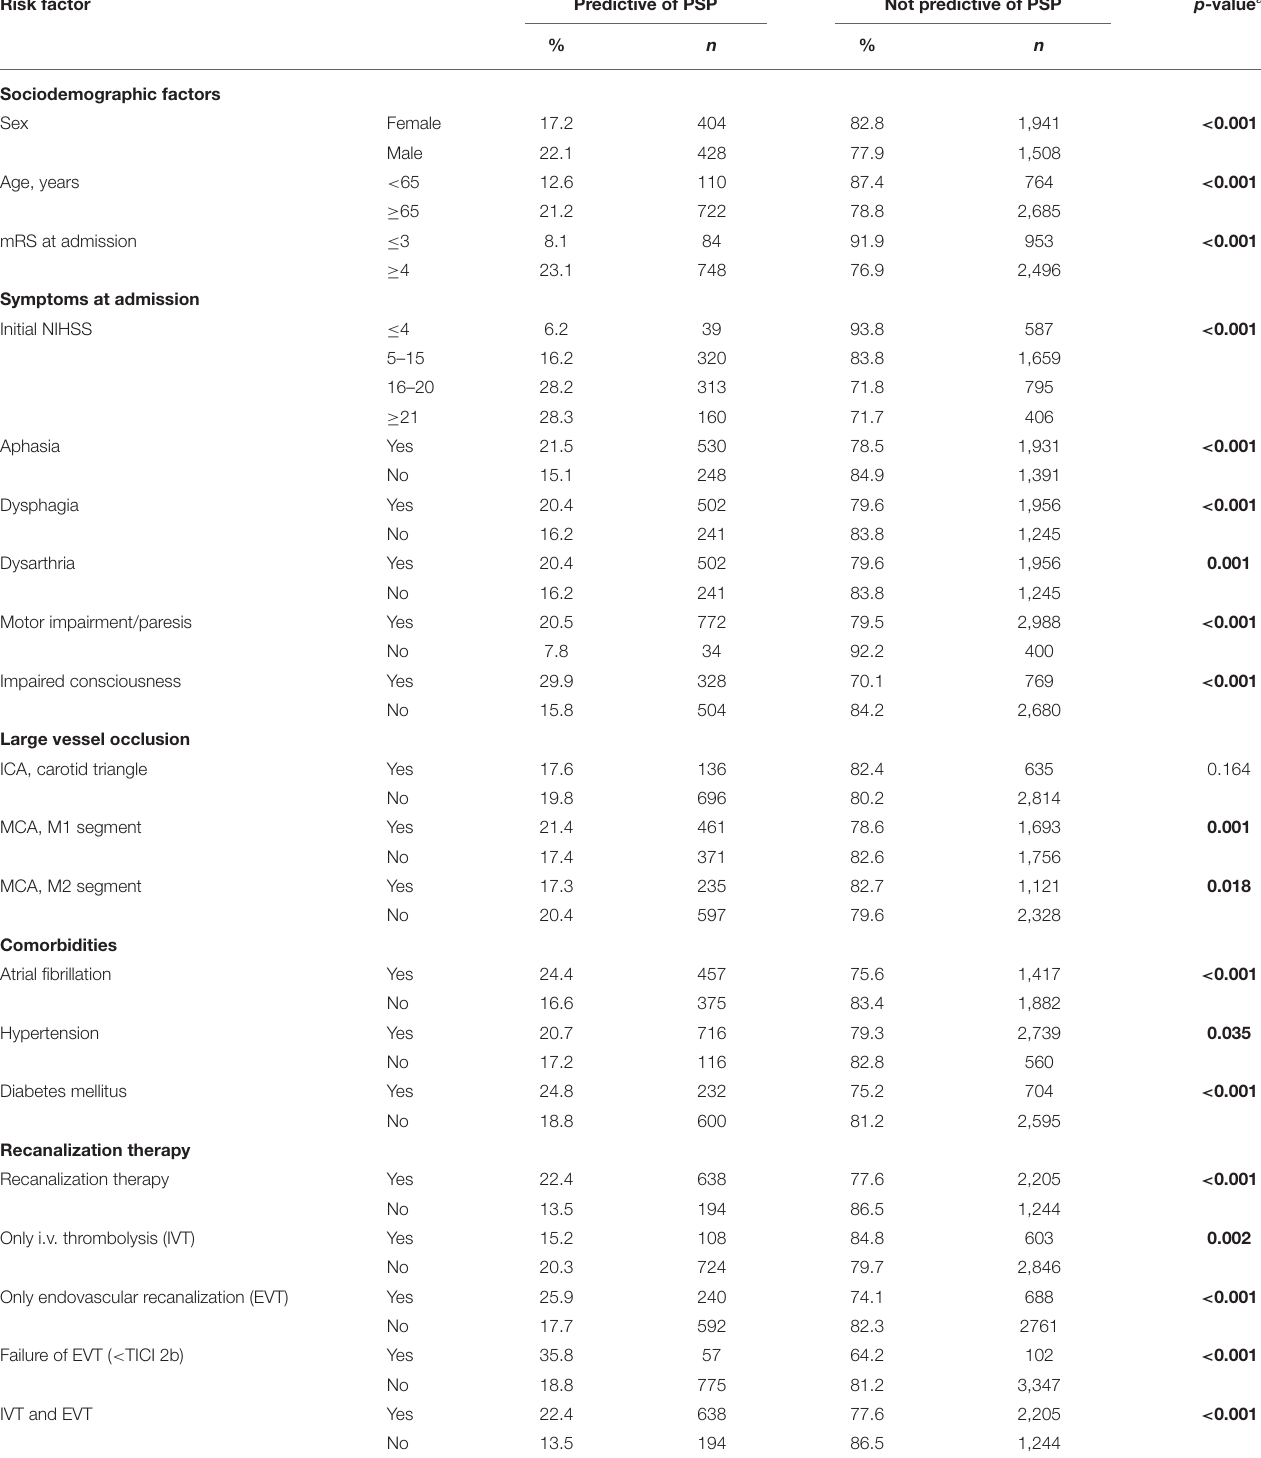
TABLE 1 | Univariate analysis of predictive factors for developing poststroke pneumonia after large vessel occlusion. Risk factor Predictive of PSP Not predictive of